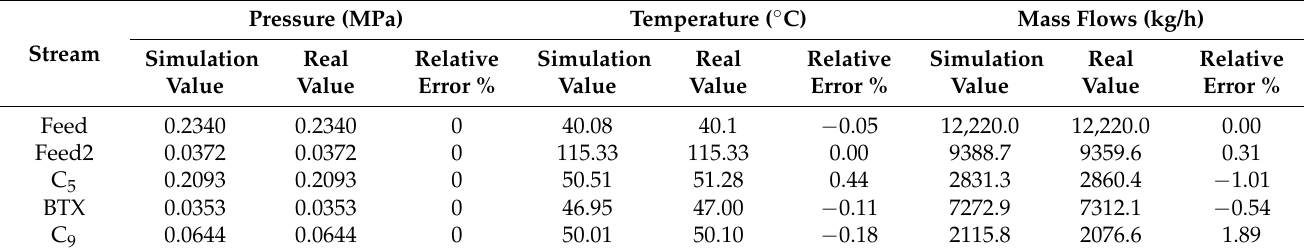
Table 1. Actual data and simulation result of hydrogenation prefractionation system.